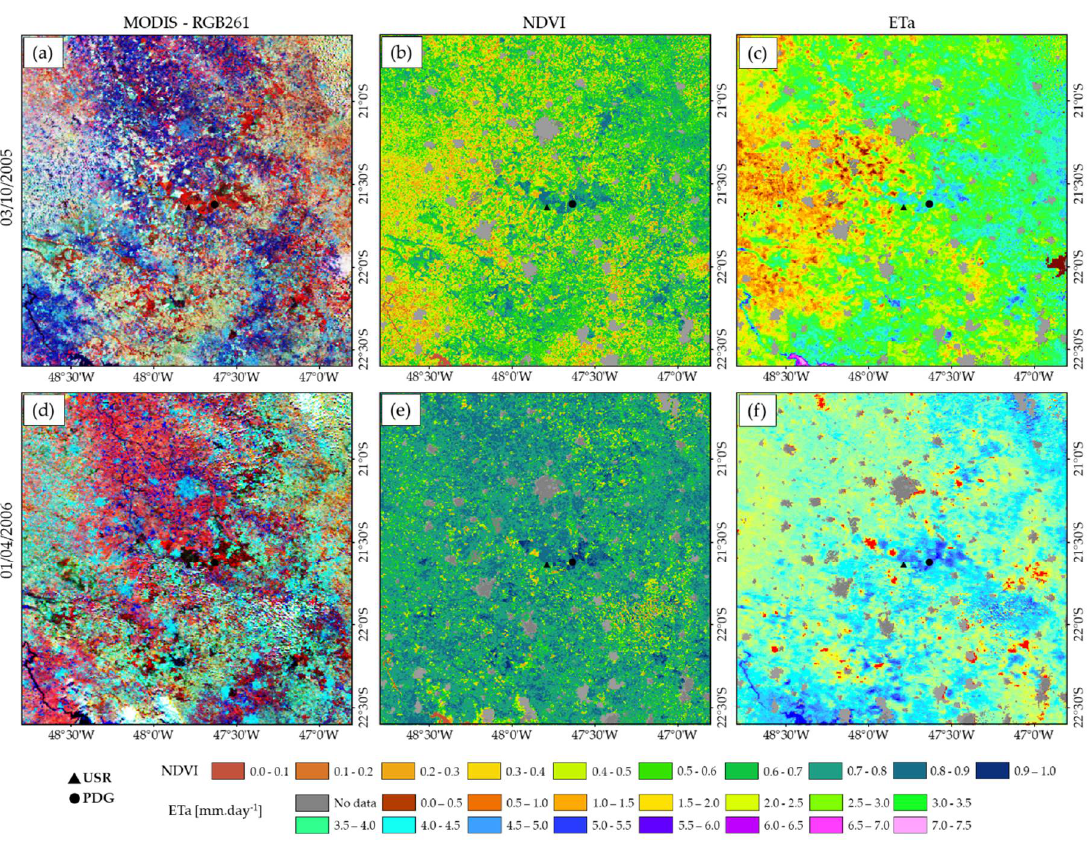
Figure 8. RGB Color composites for MODIS bands (RGB261), Normalized Difference Vegetation Index (NDVI), and actual evapotranspiration (ETa) simulated by METRIC on ( a – c ) 3 October 2005 (transition from dry to wet season) and ( d – f ) 1 April 2006 (end of wet season) for the study in northern São Paulo State (near USR and PDG sites). Gray pixels are urban areas extracted from TerraClass thematic map.